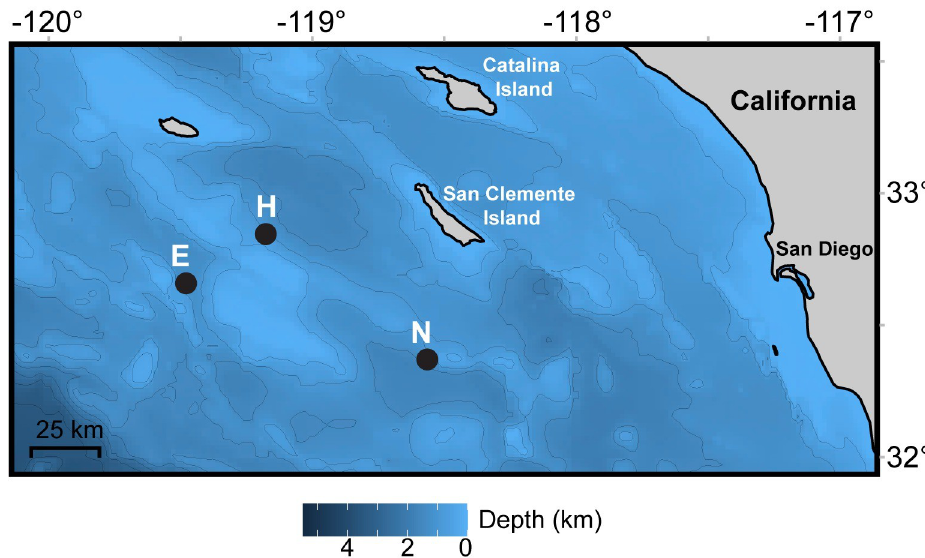
Fig 1. Map of recording locations offshore of Southern California. Recording locations H, E, and N are shown as black circles. Color bar indicates depth in kilometers and thin grey lines mark 500 m bathymetry contours. Map generated using the marmap and ggplot2 packages in R [21–23] and bathymetry data from the ETOPO1 database hosted by NOAA [24, 25].